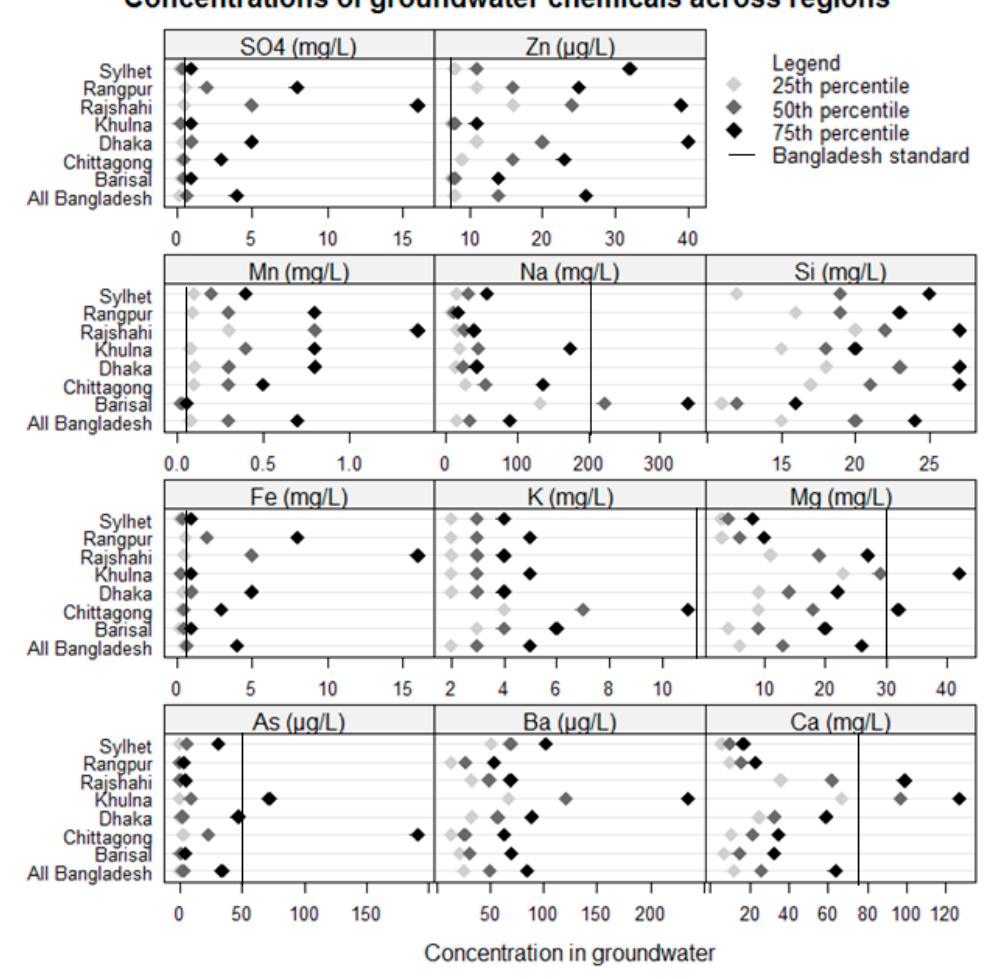
Figure 2. Concentration of groundwater chemicals across regions.